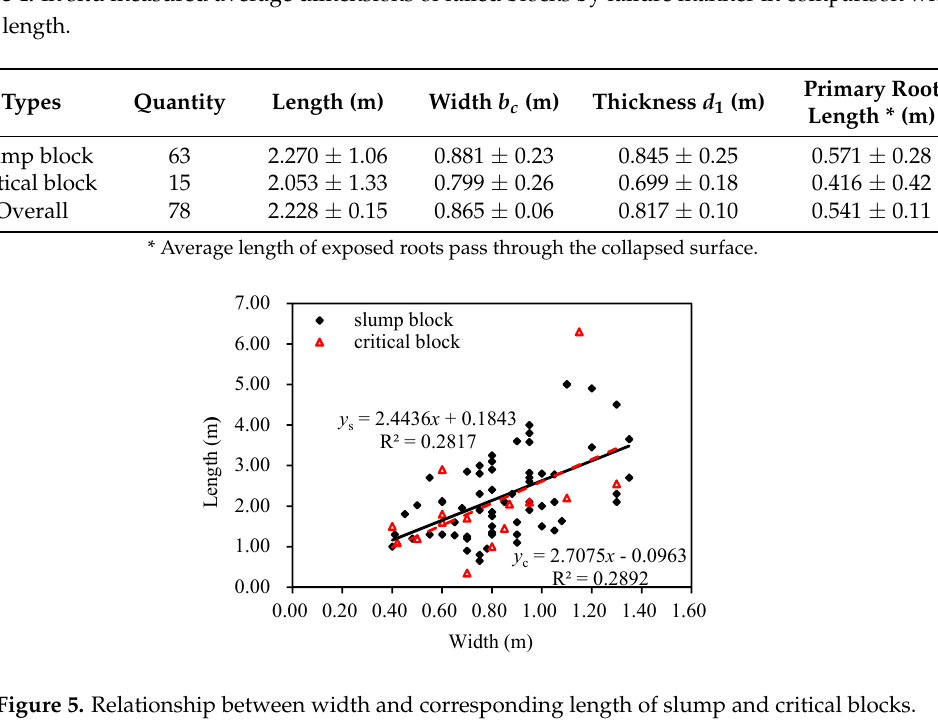
Table 3. Hydraulic parameters and morphological parameters of the study area.